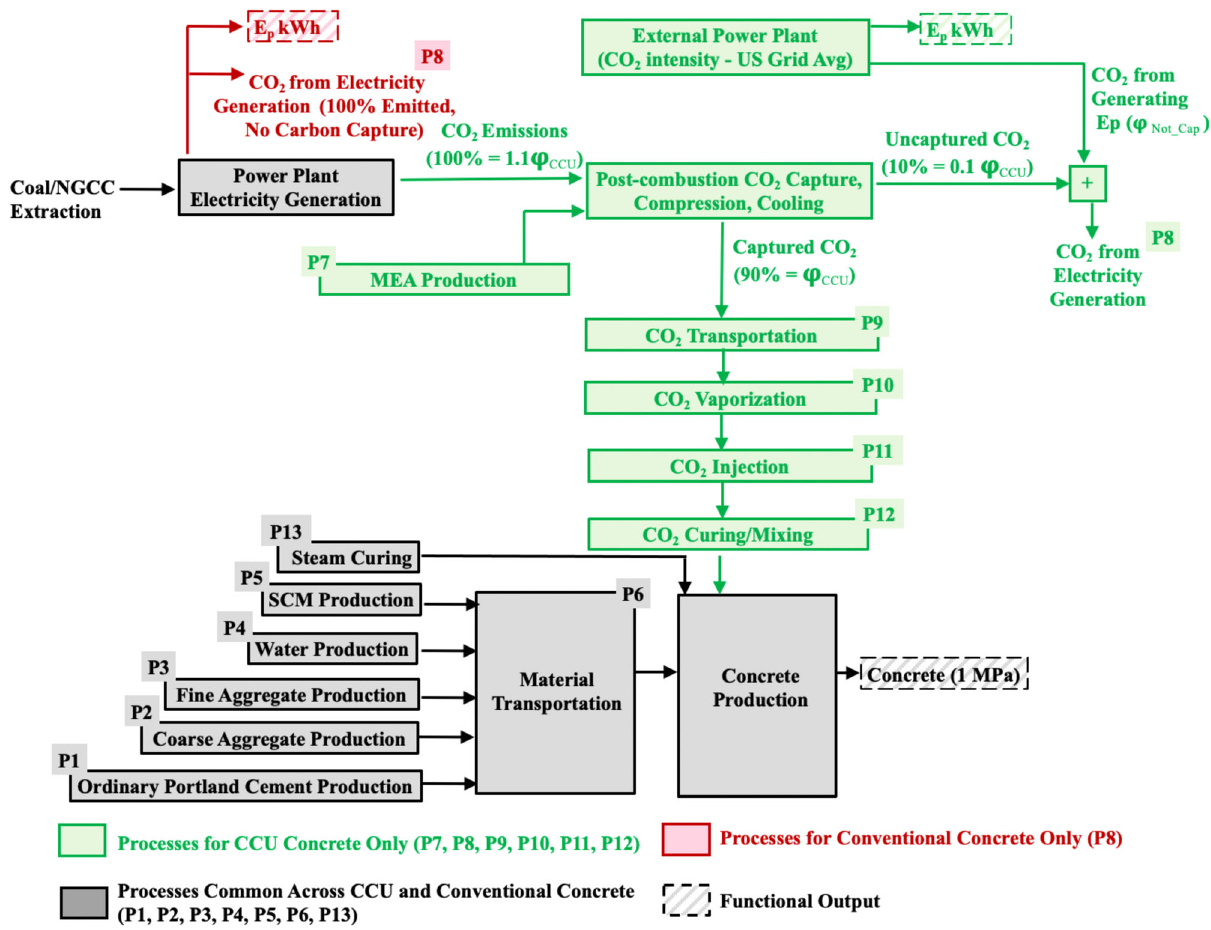
Fig. 1 The system boundary diagram depicting the 13 processes, which were accounted for when determining the net CO 2 bene fi t of CCU concrete. The processes required to produce CCU concrete are highlighted in gray and green. The processes required to manufacture conventional concrete are highlighted in gray and red. The CO 2 emissions, which is utilized in the curing or mixing of CCU concrete ( φ CCU in kg), is captured from a power plant. The energy penalty from capturing φ CCU (E p kWh) is compensated by an external power plant. When conventional concrete is produced, there is no carbon capture during electricity generation and the CO 2 from generating E p in the power plant is completely emitted. The functional unit — 1 m 3 of concrete with 1 MPa strength and E p kWh of electricity — is common across the CCU and conventional concrete production pathways. The CO 2 emissions from each of the CCU and conventional concrete production process is quanti fi ed in Eqs. 1 and